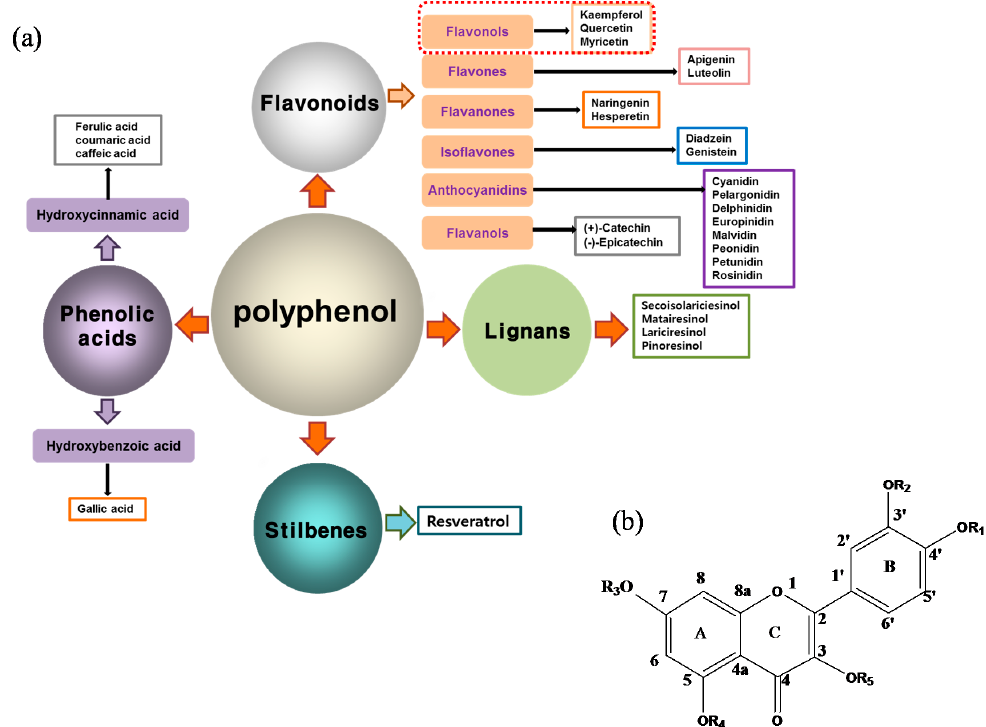
Figure 2. ( a ) Classification of polyphenols and ( b ) chemical structure of quercetin.